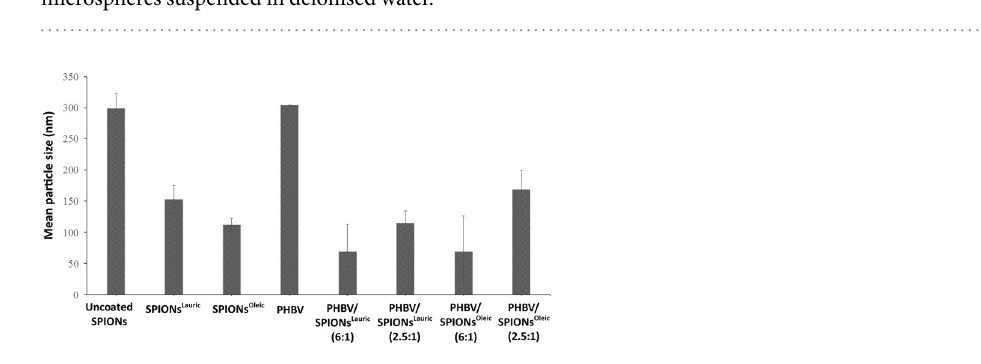
Figure 9. Zeta potential of uncoated SPIONs, SPIONs Lauric , SPIONs Oleic , PHBV and magnetic PHBV microspheres suspended in deionised water.